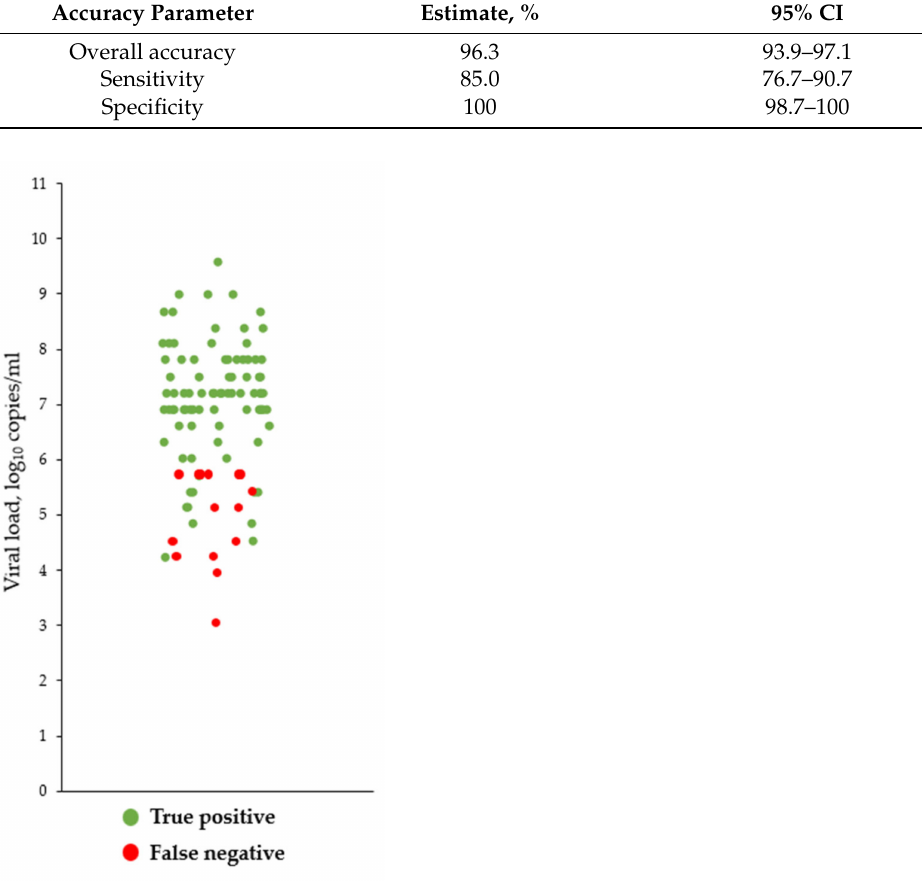
Figure 1. Distribution of true positive and false-negative samples, by viral load. Table 2. Sensitivity of the ND lateral flow test, by cycle threshold